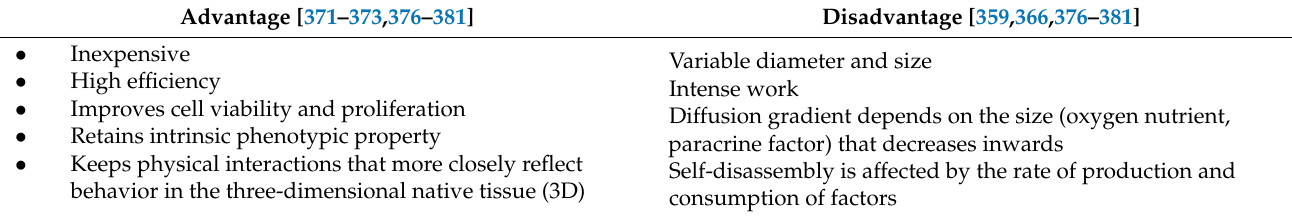
Table 6. Advantages and disadvantages of spheroid